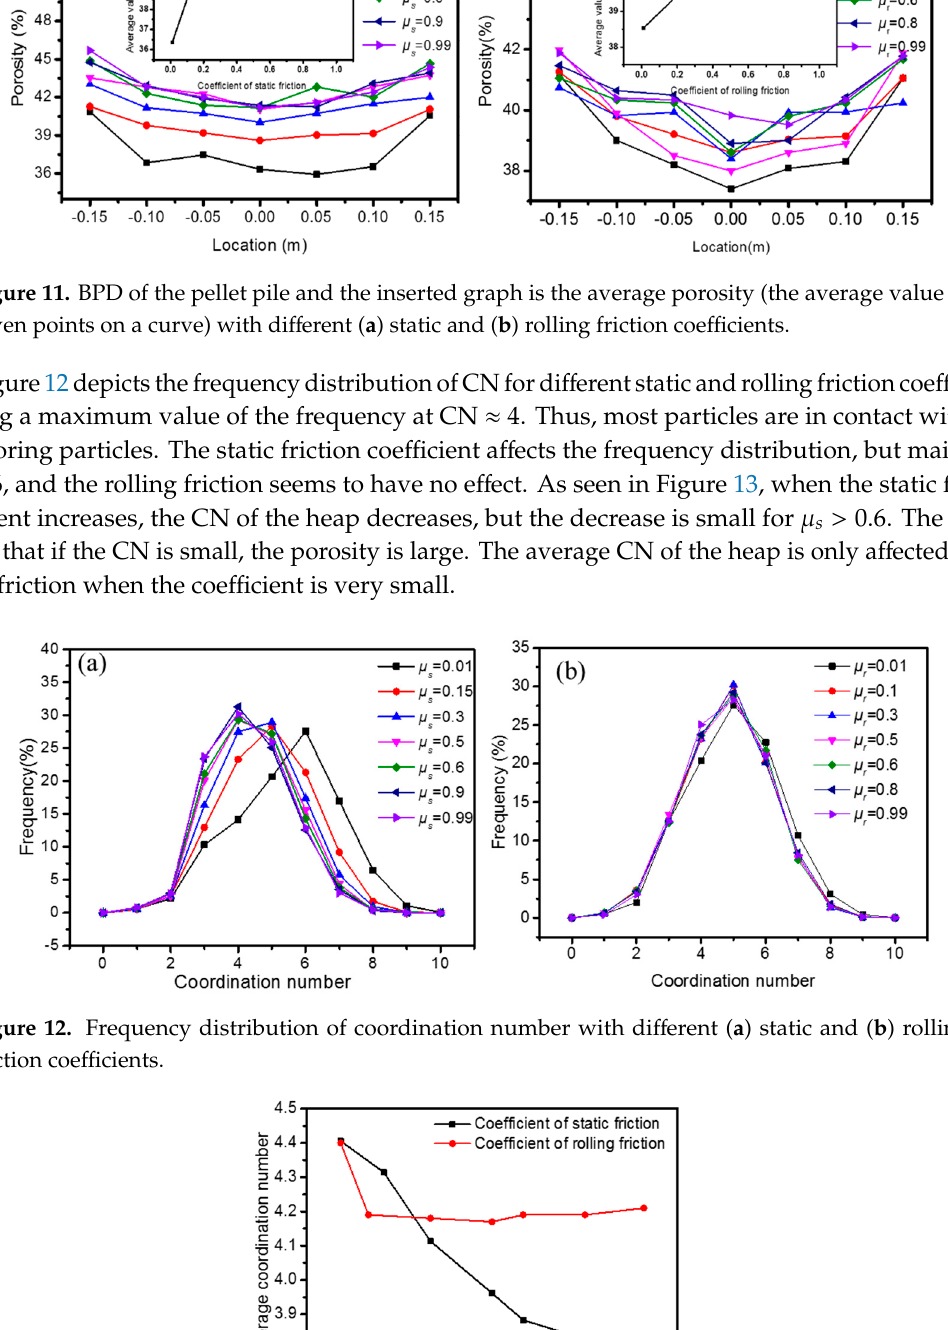
Figure 13. The average coordination number of the whole heap for different static ( 𝜇 (cid:3045) = 0.12 ) and rolling friction ( 𝜇 (cid:3046) = 0.15 ) coefficients.